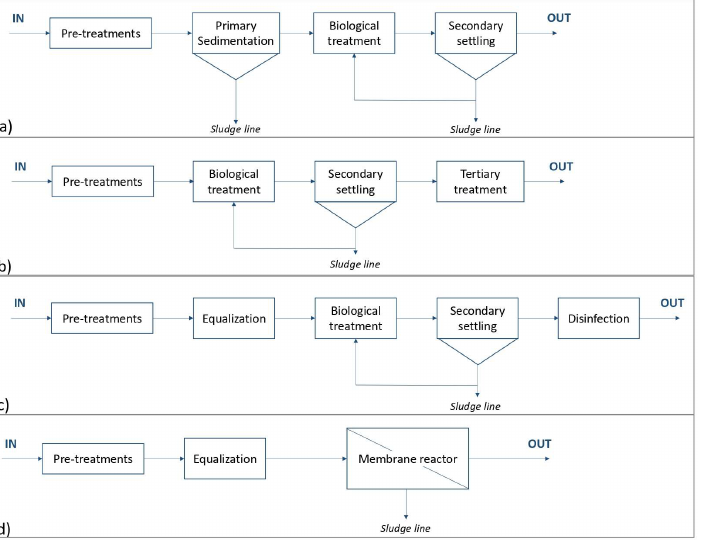
Figure 1. Process flow diagrams of the case studies: ( a ) WWTP A, ( b ) WWTP B, ( c ) WWTP C (CAS), ( d ) WWTP C (MBR).